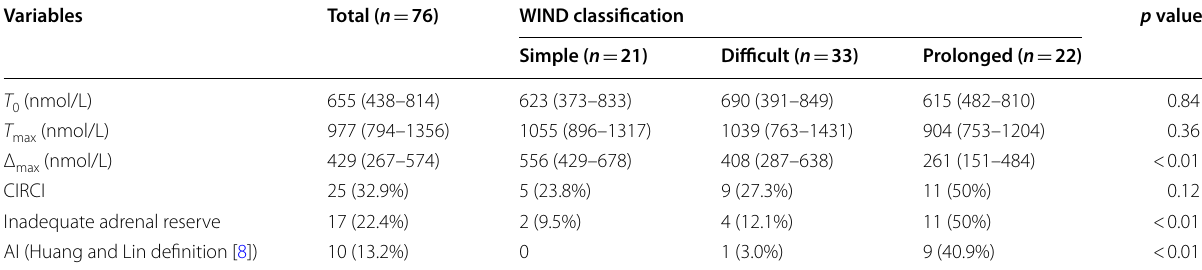
Table 2 Adrenal function of patients according to WIND classification